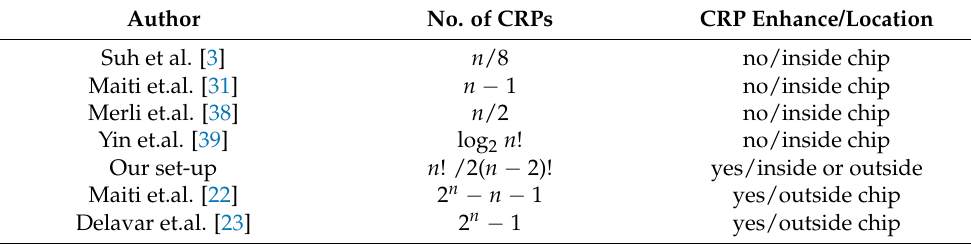
Table 5. Comparison of the numbers of CRPs.